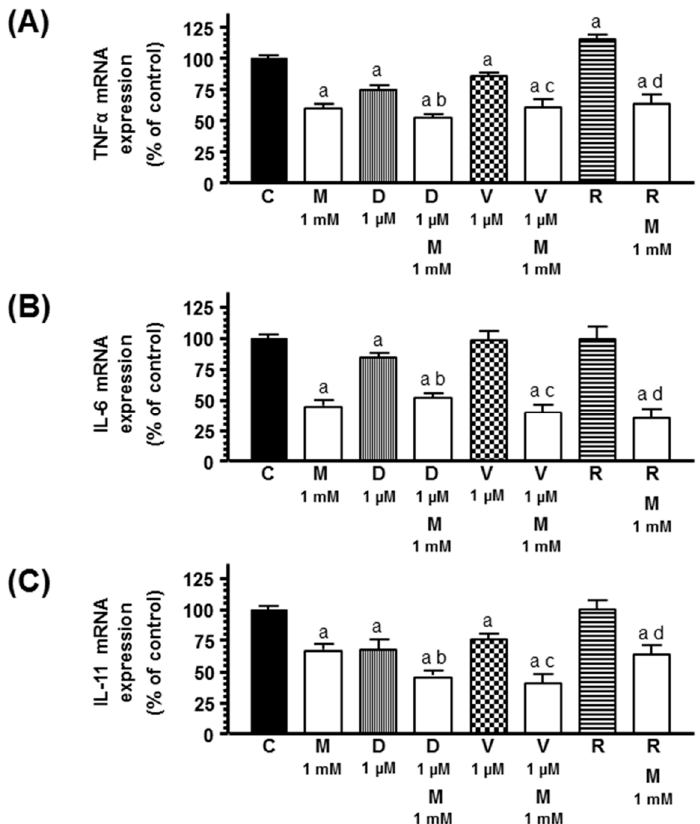
Figure 9. Effects of melatonin on docetaxel-, vinorelbine-, and radiation-induced changes on the expression of antiadipogenic cytokines: ( A ) tumor necrosis factor α (TNF α ), ( B ) interleukin 6 (IL-6), and ( C ) IL-11. Data are expressed as the percentage of control group (mean ± SEM). a, p < 0.05 vs. C; b, p < 0.05 vs. D (1 µM); c, p < 0.05 vs. V (1 µM); d, p < 0.01 vs. R. C: control, M: melatonin, D: docetaxel, V: vinorelbine, R: radiation.